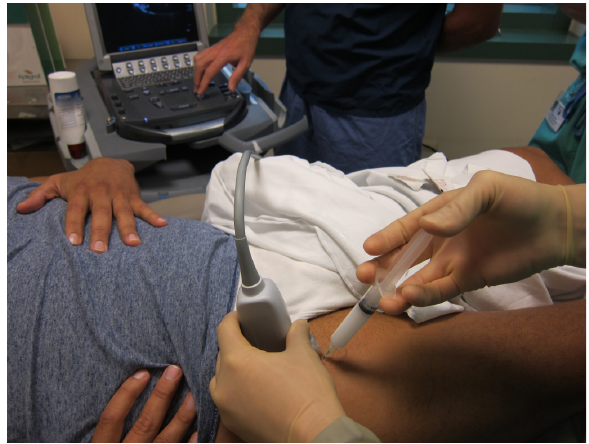
Figure 1. Set-up of ultrasound machine and patient for